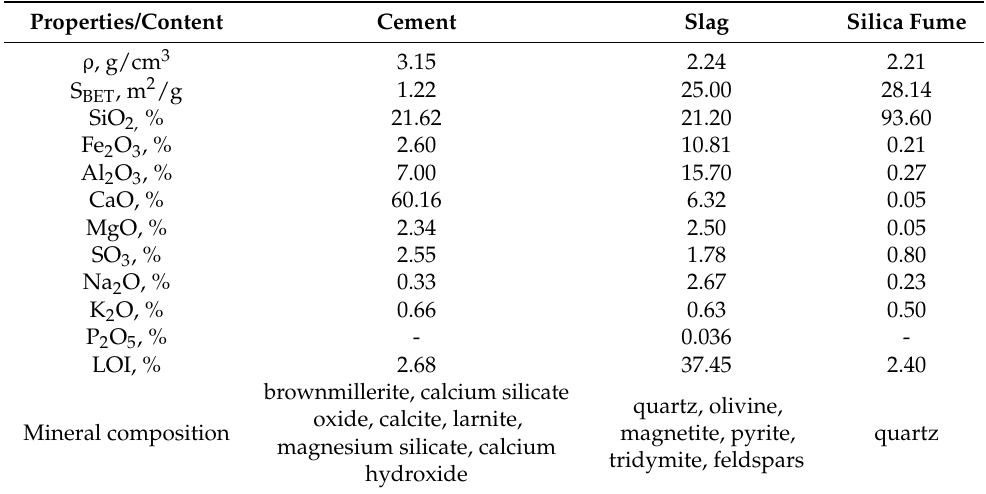
Table 1. The physical–chemical, chemical and mineralogical properties of the used cement, slag and silica fumes